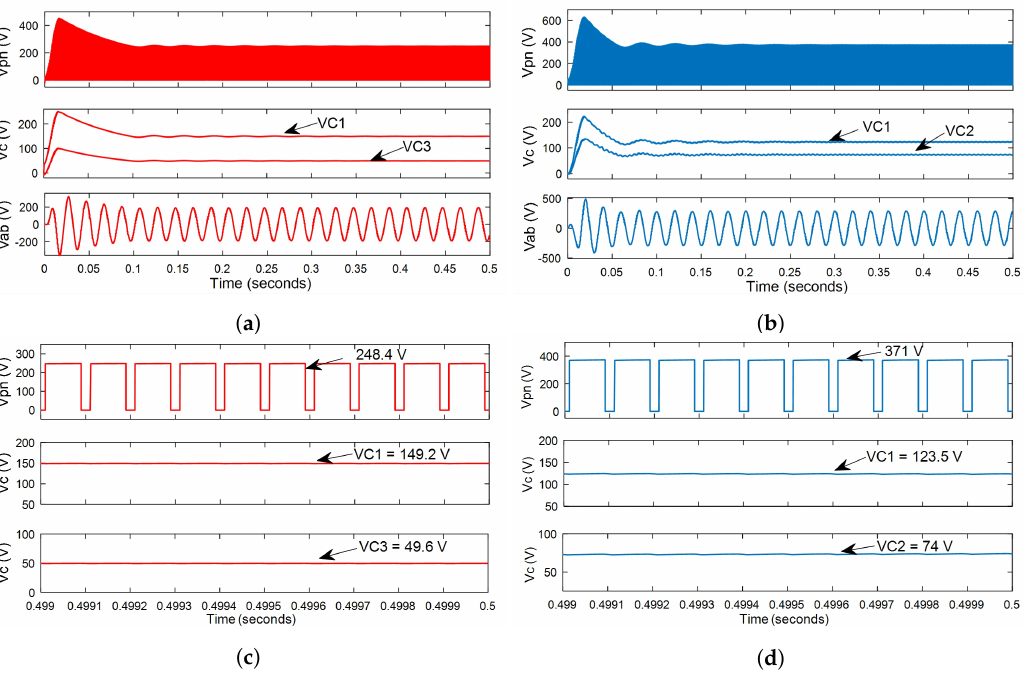
Figure 10. Simulation results (case 1): ( a ) traditional modified capacitor assisted Z-source inverter (MCA-ZSI). ( b ) Proposed SL-SBZSI. From top to bottom: DC-link voltage, V pn ; capacitor voltage, V C and output line voltage, V ab . Enlarge waveform: ( c ) traditional MCA-ZSI. ( d ) Proposed SL-SBZSI. From top to bottom: DC-link voltage, V pn ; capacitor voltage; V C 1 and capacitor voltage; V C 3